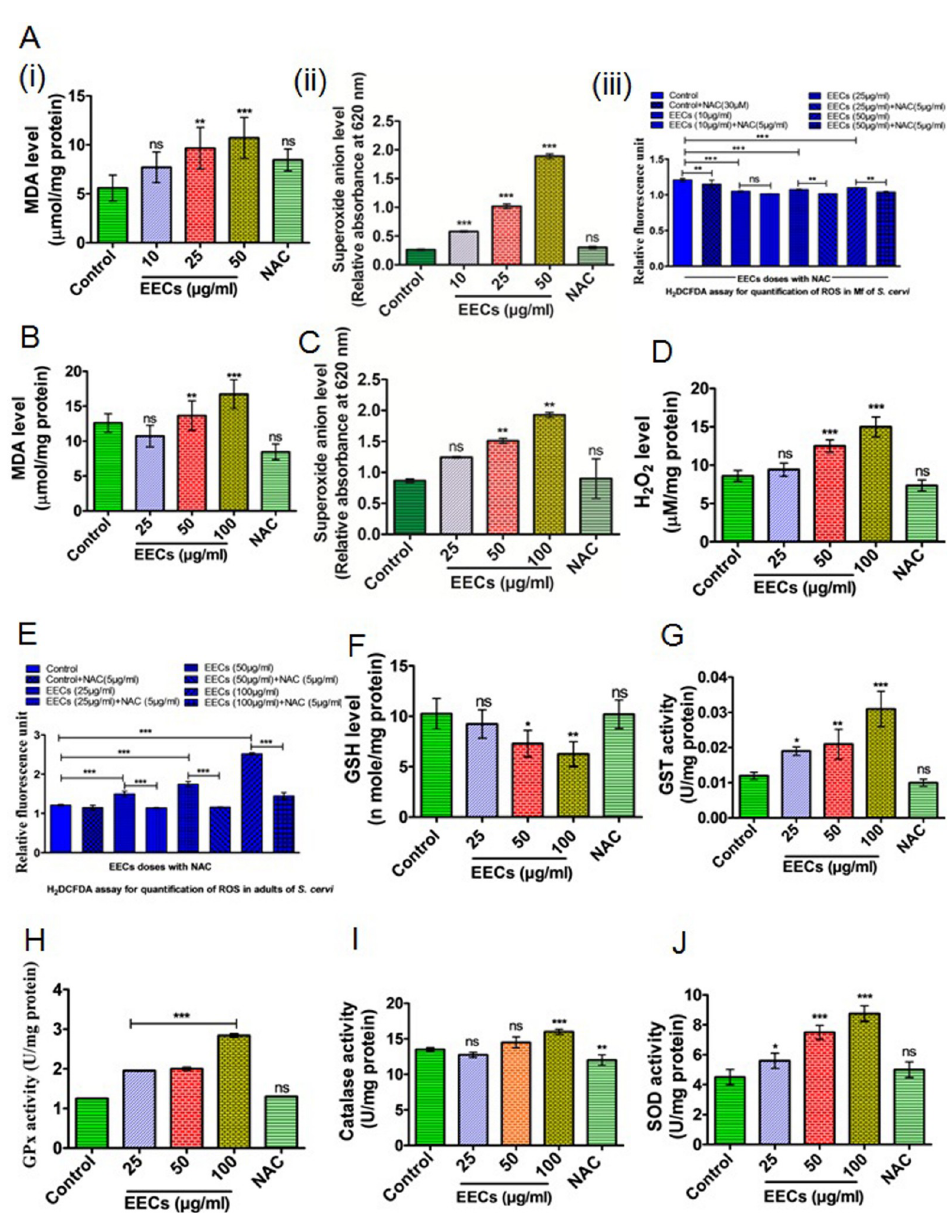
Fig 4. EECs induces oxidative stress in S . cervi microfilariae (Mf) and adults. (A.). Levels of (i) Malondialdehyde, (ii) Superoxide anion, and (iii) total ROS generated in the microfilarial stage of S . cervi . (B.) Malondialdehyde, (C.) Superoxide anion, and (D.) H 2 O 2 in the EECs treated parasites. (E.) Level of total ROS generation in S . cervi adults after EECs treatment. (F.) Level of reduced glutathione (GSH) in EECs treated parasites. Alteration in the activities of the cellular antioxidant enzymes viz. (G.) Glutathione-S-transferase, (H.) Glutathione peroxidase, (I.) catalase and (J.) SOD in EECs treated S . cervi . Each data was obtained from the five independent experiments and replicated for at least three times. Data in the bar graph represents mean ± SEM and p < 0.001 considered as statistically significant.